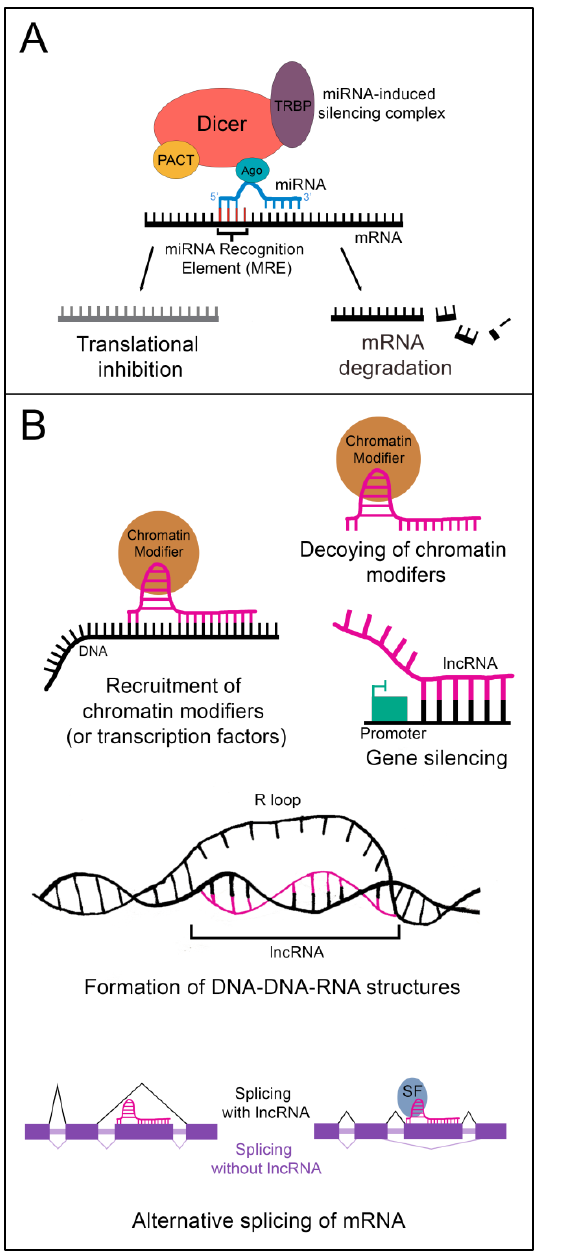
Figure 2. Epigenetic regulation by ncRNAs. ( A ) The microRNA-induced silencing complex down- regulates mRNAs through translational inhibition or degradation. TRBP: transactivation response element RNA-binding protein; PACT: protein kinase RNA activator; Ago: Argonaute ( B ) lncRNAs alter gene expression by binding DNA, binding mRNA, or by sequestering chromatin modifiers. DNA binding by lncRNAs can result in chromatin modifier or transcription factor recruitment, gene silencing, or the formation of DNA-DNA-RNA structures. Binding of a lncRNA to mRNA often